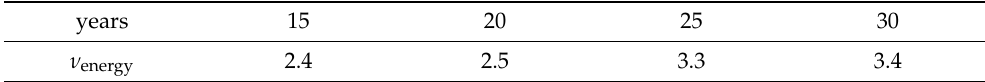
Table 6. Energy impact ratio between RESCATAME and baseline solution.